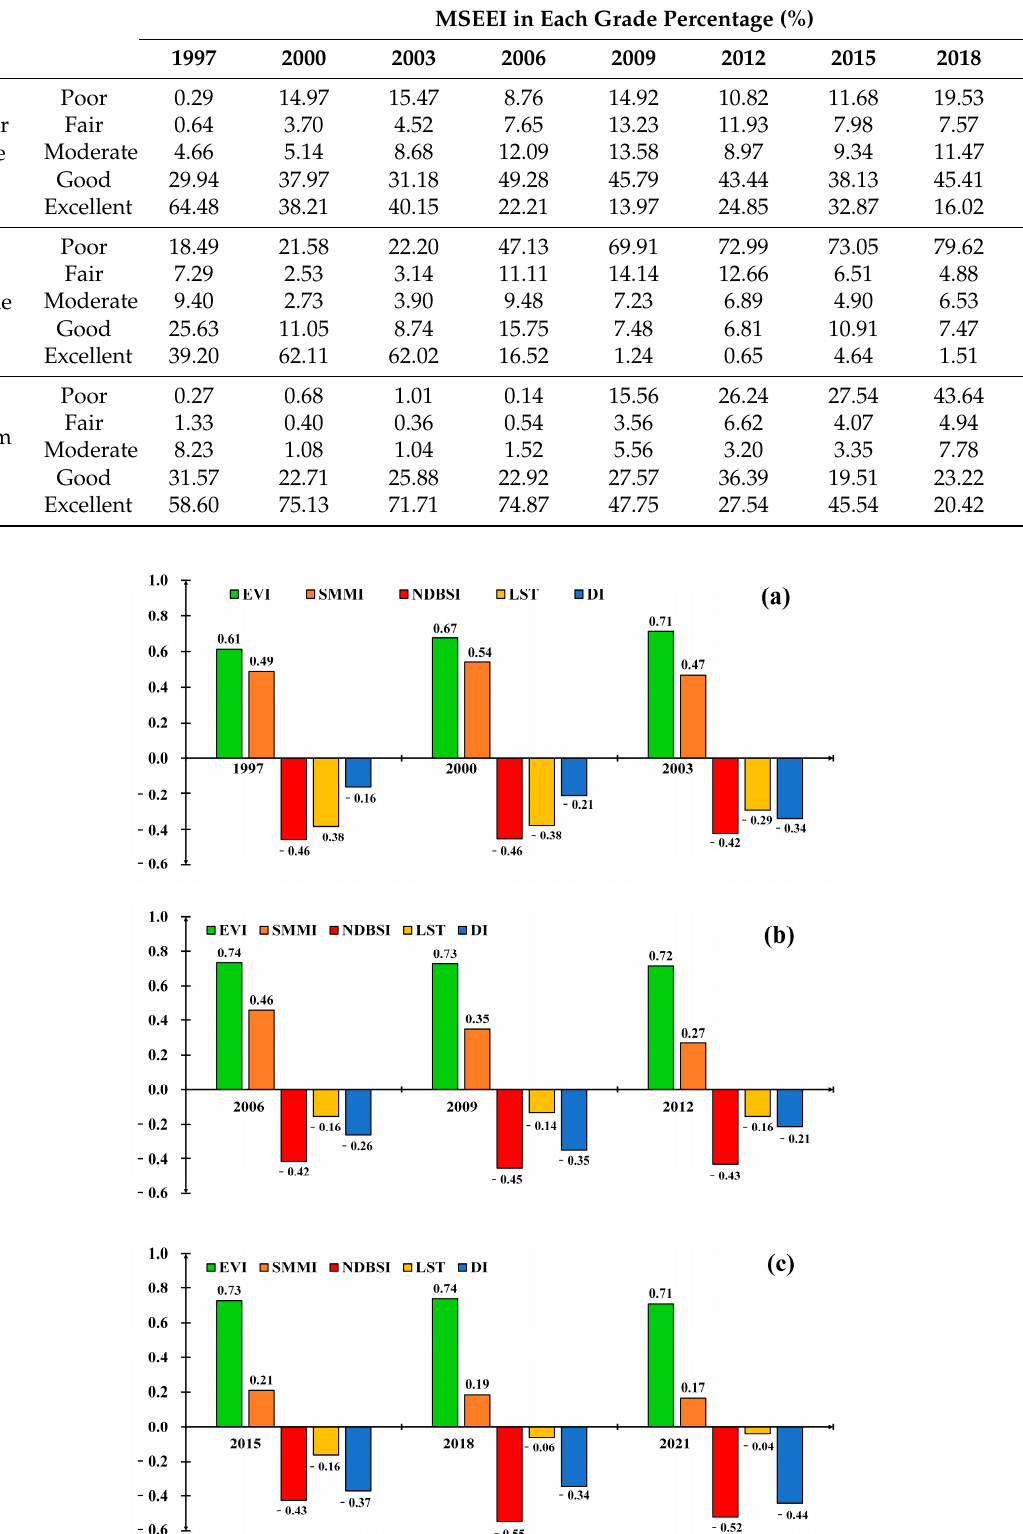
Figure 5. The EVI, SMMI, NDBSI, LST, and DI load on PC1 in 1997, 2000, 2003 ( a ); the EVI, SMMI,